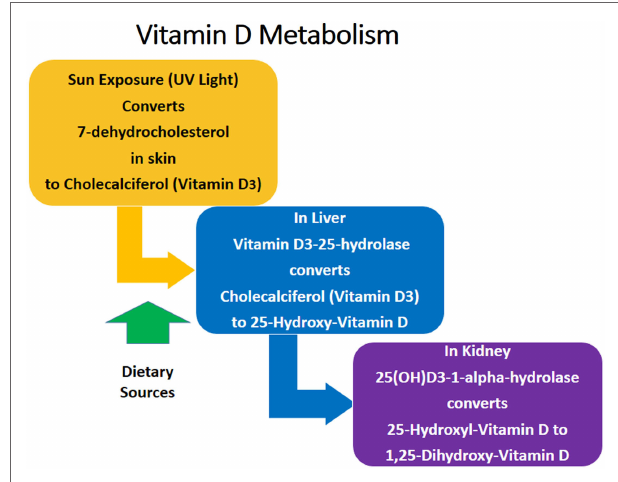
FiGURe 1 | vitamin D metabolism